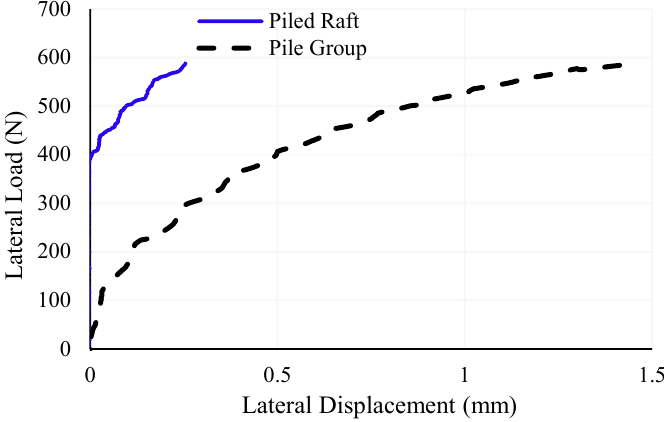
Figure 23. 9-piled raft vs. 9-pile group response under lateral load.